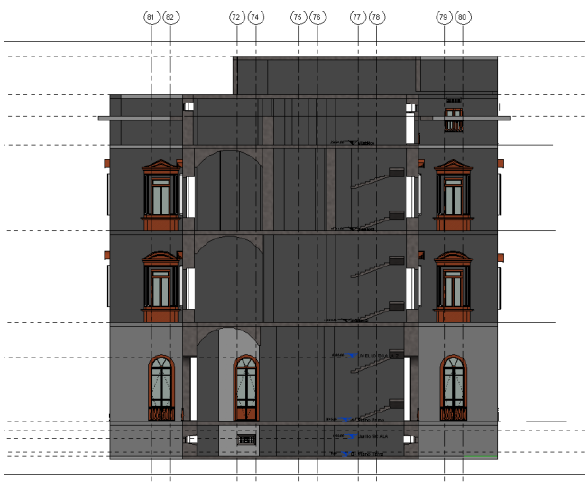
Figure 10 Naples Section of the Federico II building on the main staircase. 3D model (2018)